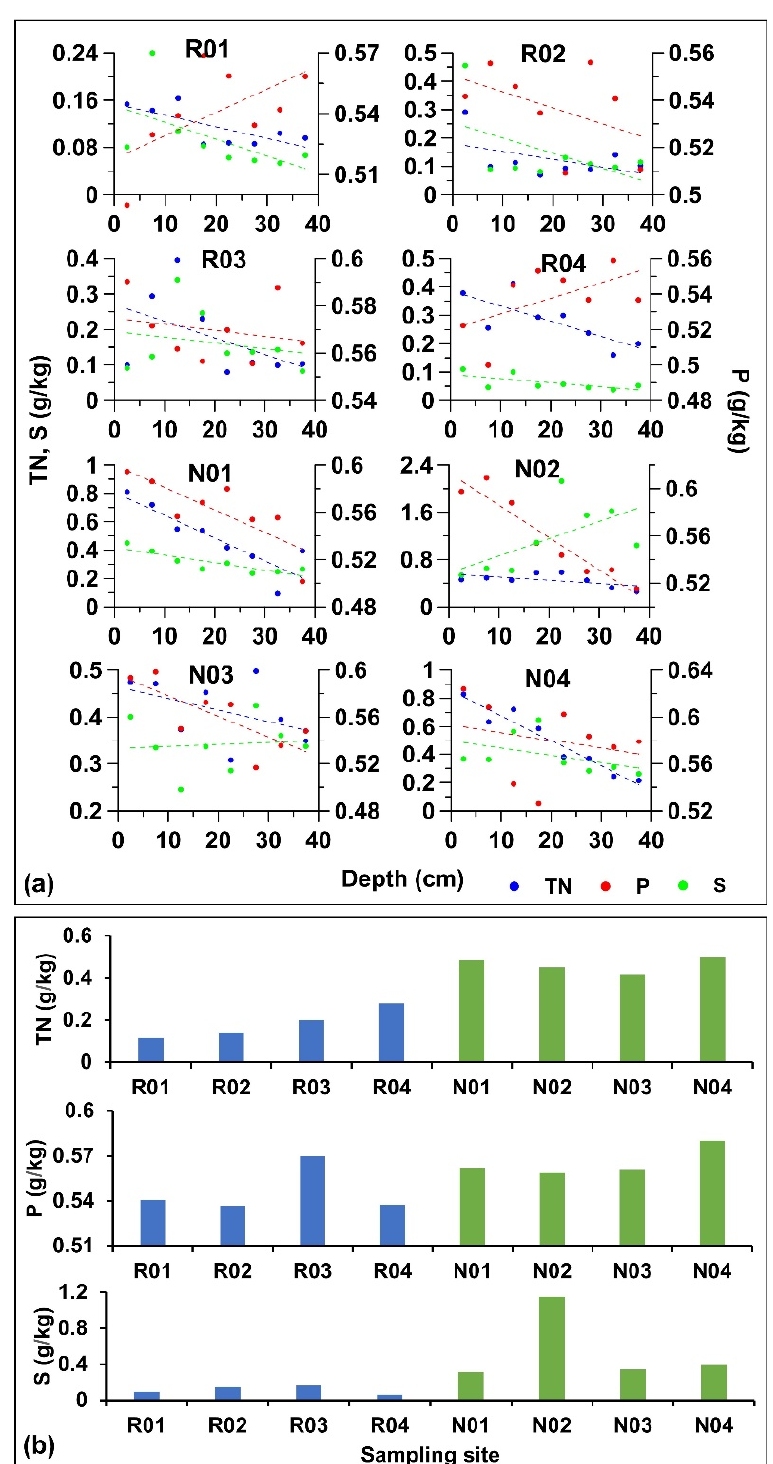
Figure 4. Comparison of changes in TN, P, and S content with depth at each sampling site. ( a ) The change in TN, P, and S content with depth; ( b ) the mean TN, P, and S content at each sampling site.